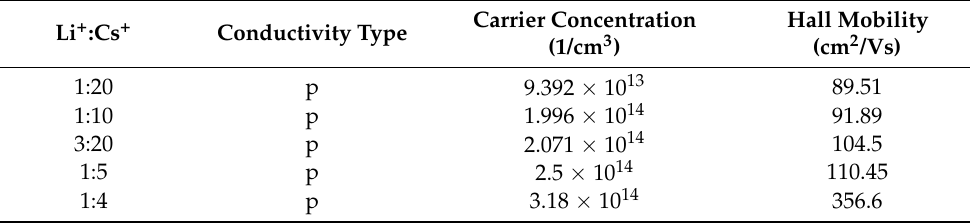
Table 2. Hall effect data of Li + doped Cs 2 SnI 6 with different